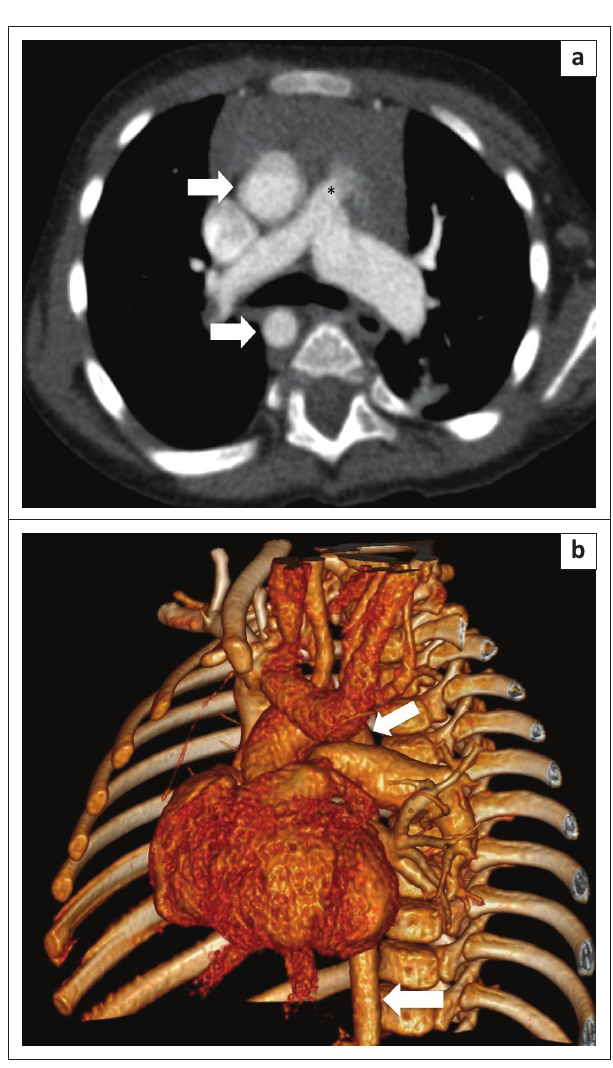
FIGURE 3: Right-sided aortic arch in a young boy with TOF. Thin-section axial contrasted CT (a) demonstrates a right-sided aortic arch (arrows) and stenosis of the main pulmonary artery (asterisk). Volume rendered CT (b) chest demonstrates the right-sided aortic arch